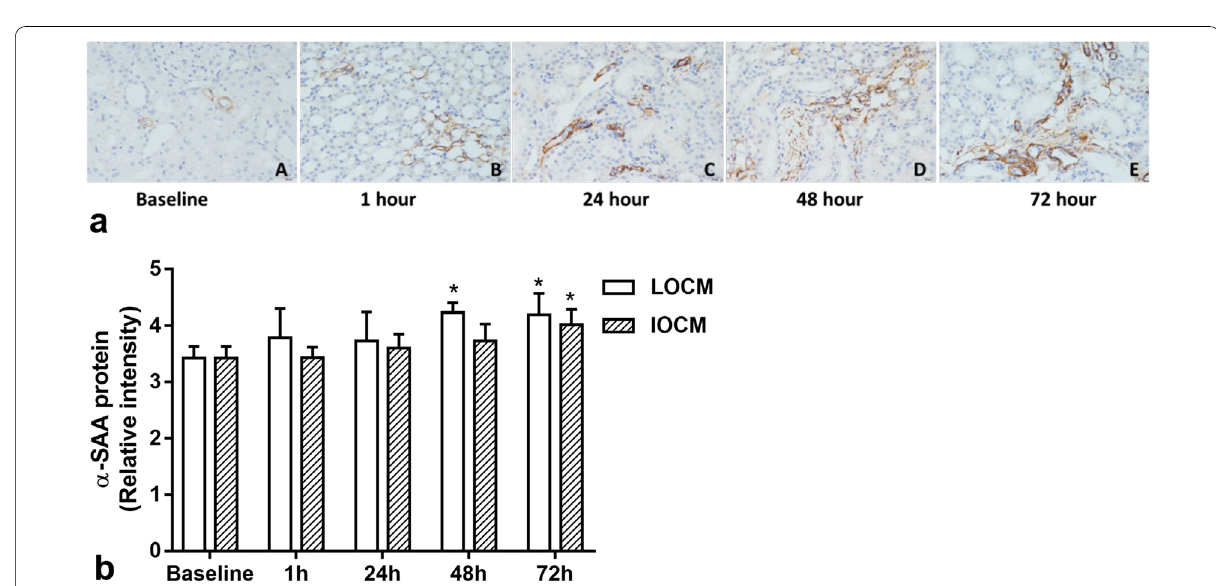
Fig. 6 a Expression of α-SMA in rat kidney at different time points. b The histogram of expression level of α-SMA in kidney of rats before and after injection of contrast agent. *Represents p < 0.05 versus baseline